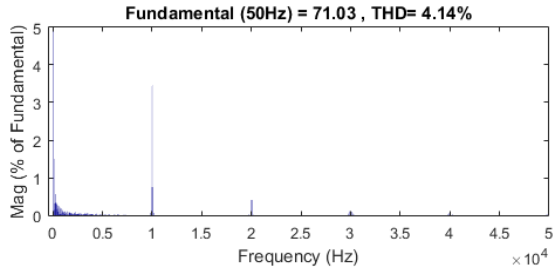
Energies 2020 , 12 , x FOR PEER REVIEW Figure 14. Spectrum of the phase current for the conventional MPDTC. Figure 14. Spectrum of the phase current for the conventional MPDTC. Figure 14. Spectrum of the phase current for the conventional MPDTC.